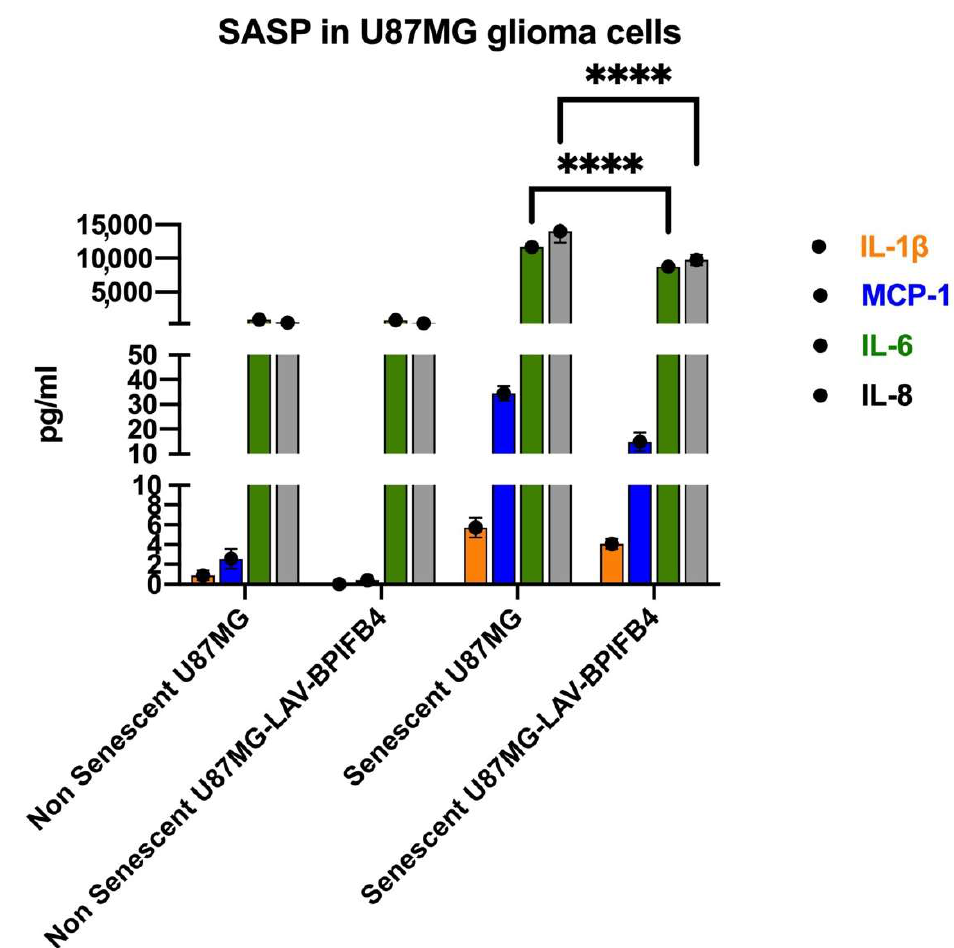
Figure 2. Cytokine analysis of Senescent U87-MG glioblastoma cell line. Secretory profile of U87-MG glioma cell line after 24 h treatment with etoposide (6 μM) and 5 days resting in the presence or absence of 18 ng/mL of rhLAV-BPIFB4 for the last 48 h as detected by multiplex ELISA of the cell medium. The etoposide induced the secretion of some SASP factors: IL-1β, MCP1, IL-6, and IL-8; the 48 h treatment with rhLAV-BPIFB4 modulated this secretory phenotype. Statistical analysis by two-way ANOVA with Tukey’s test for multiple comparison was conducted. (**** p < 0.0001).